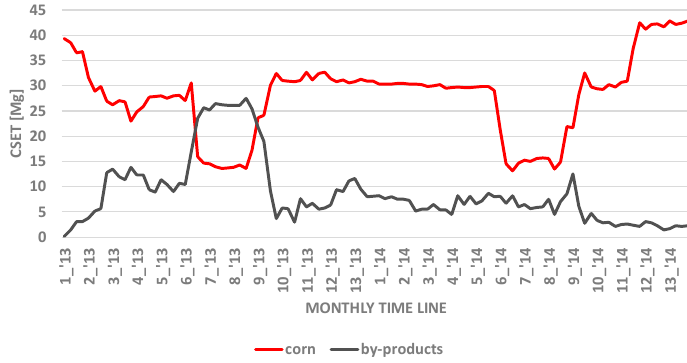
Figure 2. Monthly real biogas plant diet in the 2013–2014 biennium.